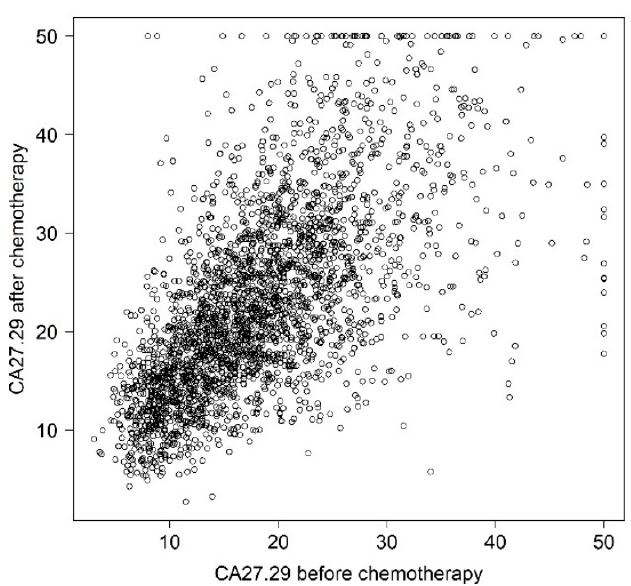
Figure 1. CA27.29 before chemotherapy versus CA27.29 after chemotherapy. Outliers were trun- cated at 50 U/mL. at 50